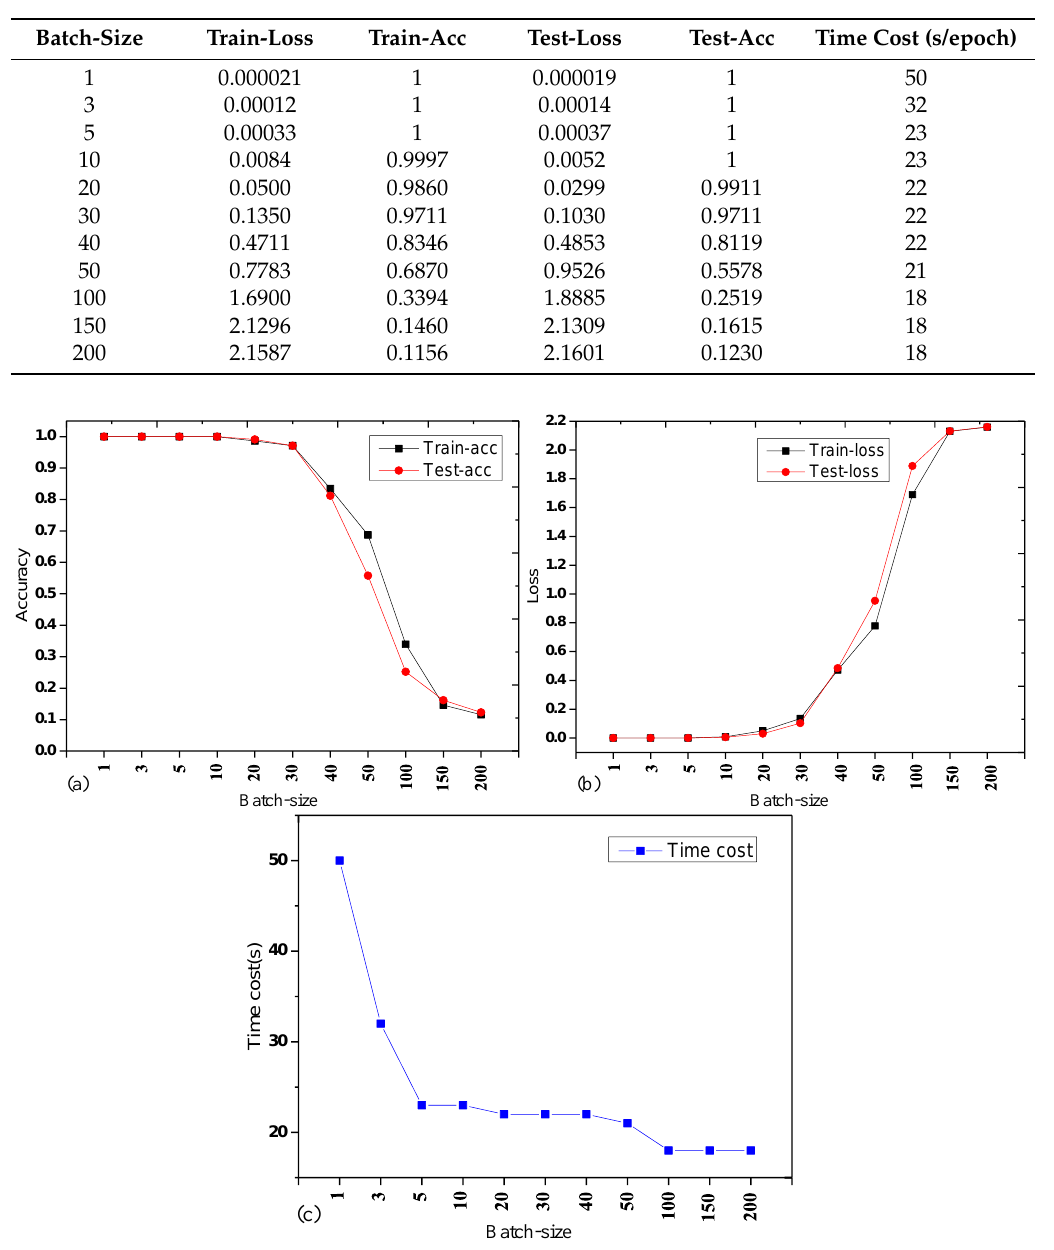
Figure 9. The training and testing results under different batch-sizes. ( a ) Accuracy; ( b ) loss; ( c ) time cost.